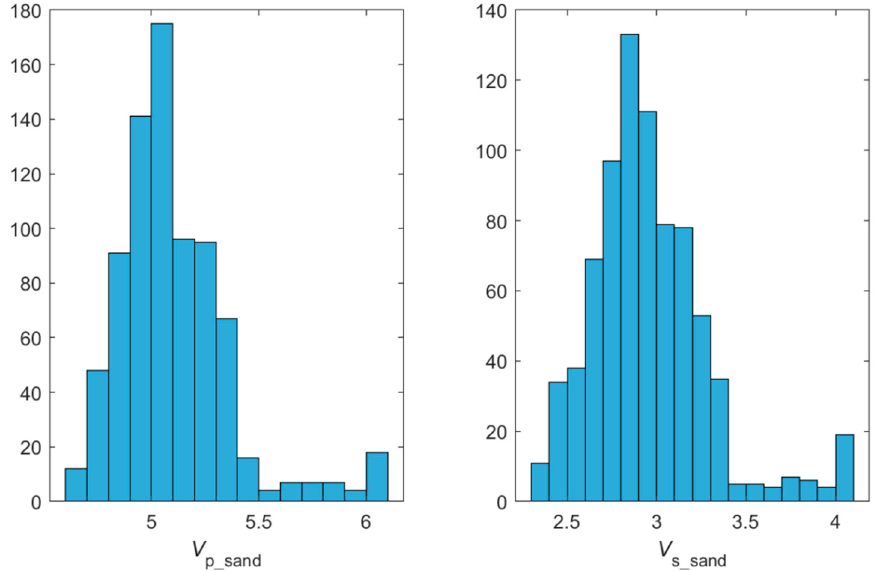
Figure 4. Prior information of statistical sand velocity in the reference section.